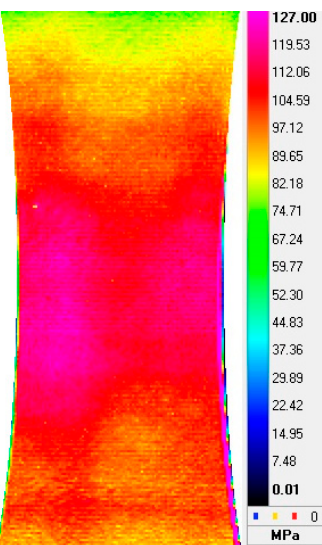
Figure 5. The bulk stress field in the 7075 coating at 3,011,000 cycles.